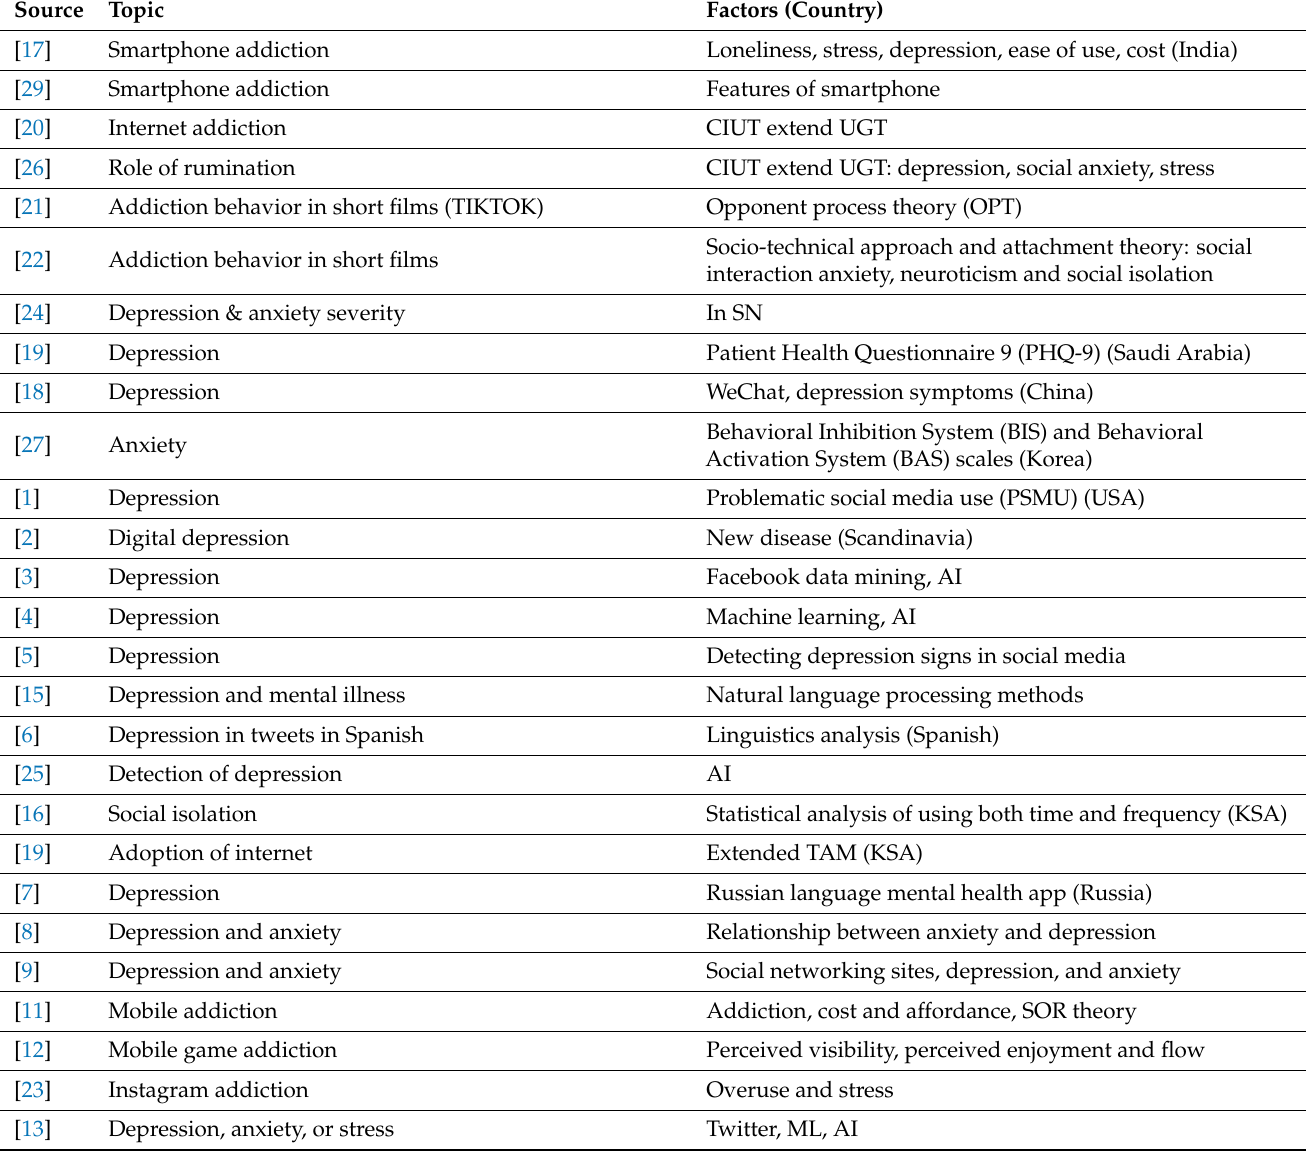
Table 1. Studies pertain to addiction, depression, and anxiety in using